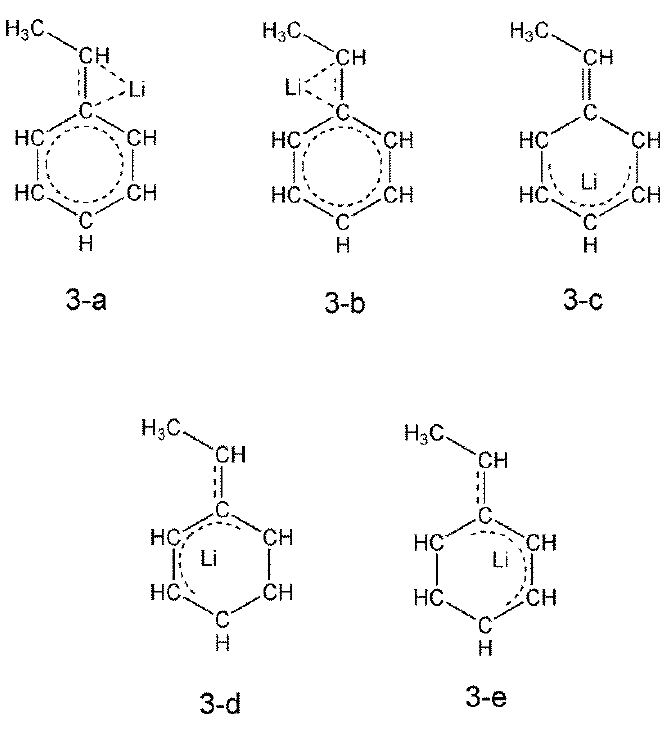
Figure 3. Schematic structural formulae of HStLi.